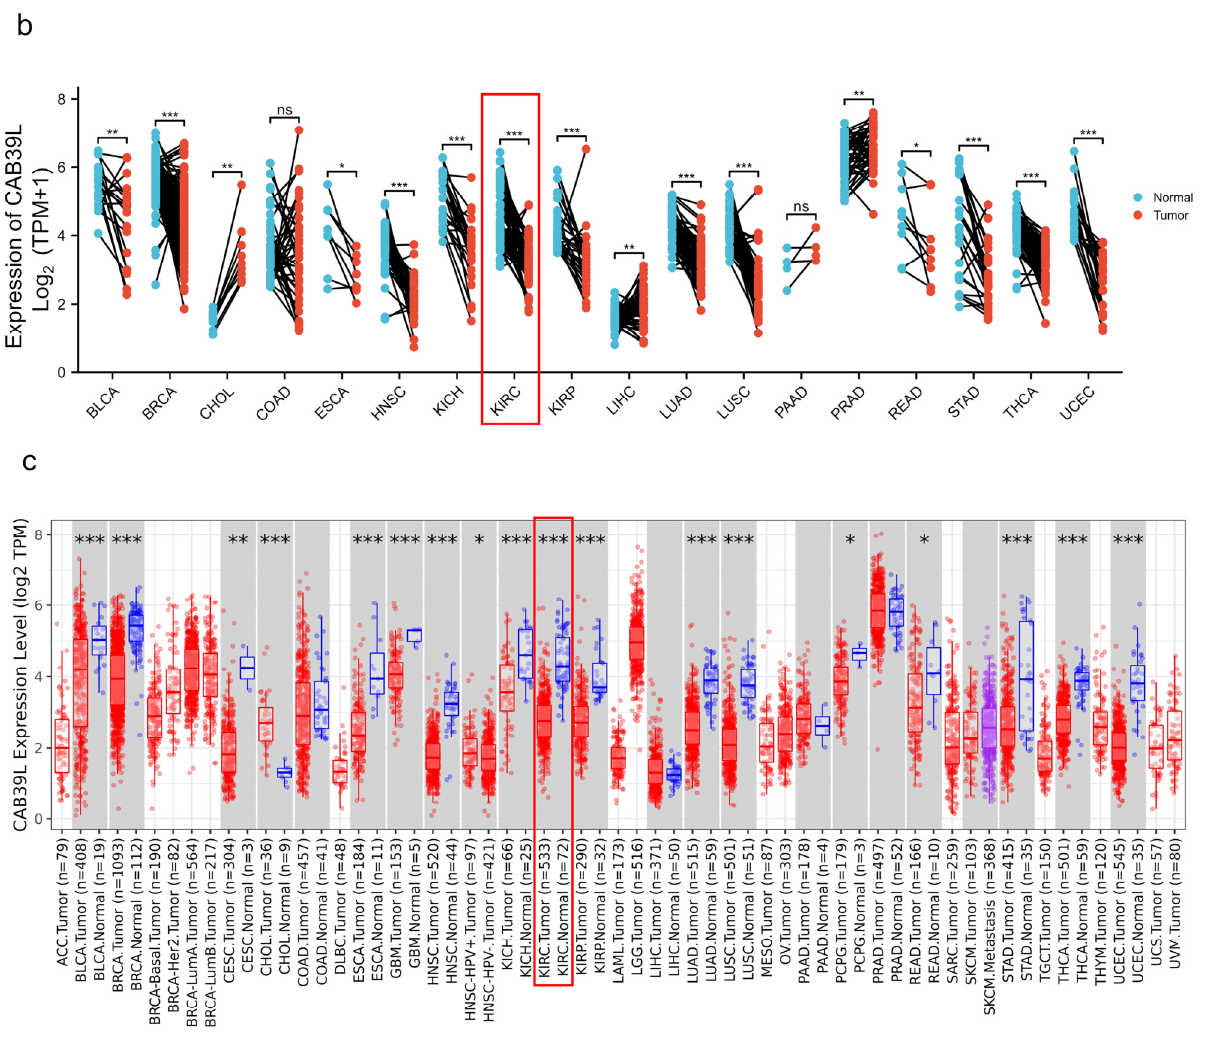
Figure 1. The mRNA level of CAB39L in different types of cancer. ( a ) mRNA expression of CAB39L in 33 types of cancer (TCGA). ( b ) mRNA expression of CAB39L in tumor and paired paracancerous samples (TCGA). ( c ) mRNA expression of CAB39L in 33 types of cancer (TIMER). ACC: adrenocortical carcinoma; BLCA: bladder urothelial carcinoma; BRCA: breast invasive carcinoma; CESC: cervical squamous cell carcinoma and endocervical adenocarcinoma; CHOL: cholangiocarcinoma; COAD: colon adenocarcinoma; DLBC: lymphoid neoplasm diffuse large B-cell lymphoma; ESCA: esophageal carcinoma; GBM: glioblastoma multiforme; HNSC: head and neck squamous cell carcinoma; KICH: kidney chromophobe; KIRC: kidney renal clear cell carcinoma; KIRP: kidney renal papillary cell carcinoma; LAML: acute myeloid leukemia; LGG: brain lower grade glioma; LIHC: liver hepatocellular carcinoma; LUAD: lung adenocarcinoma; LUSC: lung squamous cell carcinoma;